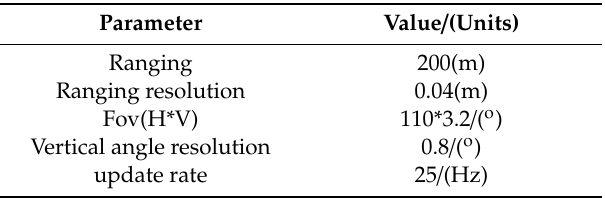
Table 2. Main technical parameters of the